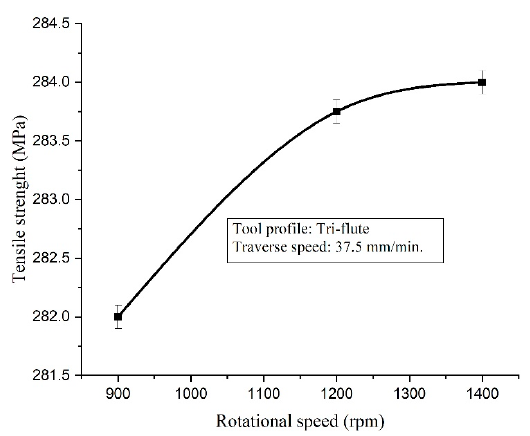
Figure 12. Influence of rotational speed on tensile strength.